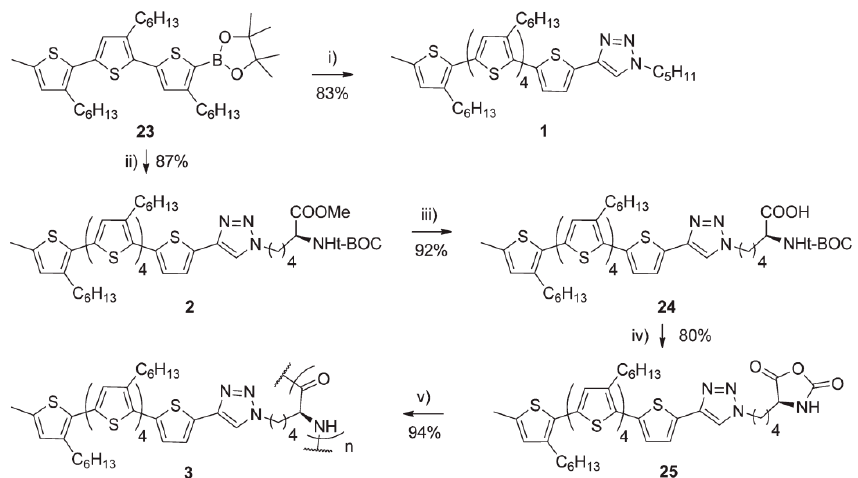
Figure 6. Synthetic route for the preparation of Semiconductor Functionalized Peptide. Reagents and